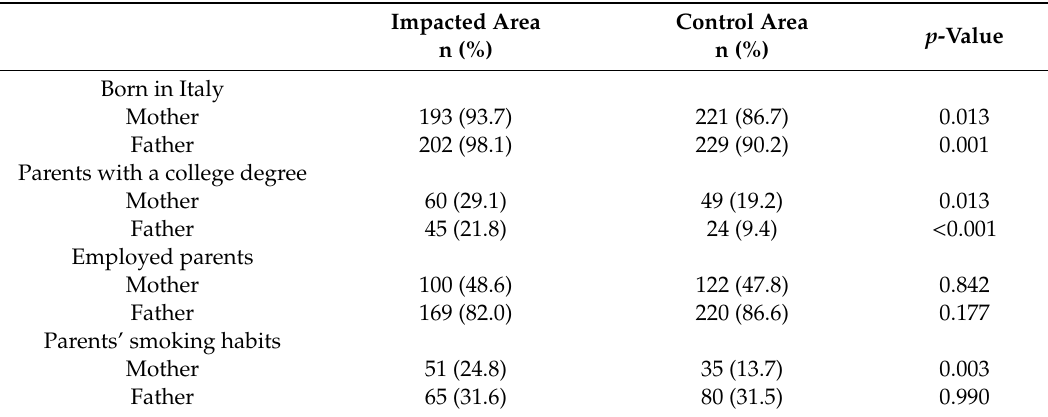
Table 3. Characteristics of the children’s parents in the two